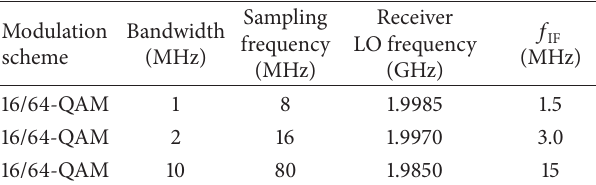
Table 1: LO frequencies for the low-IF